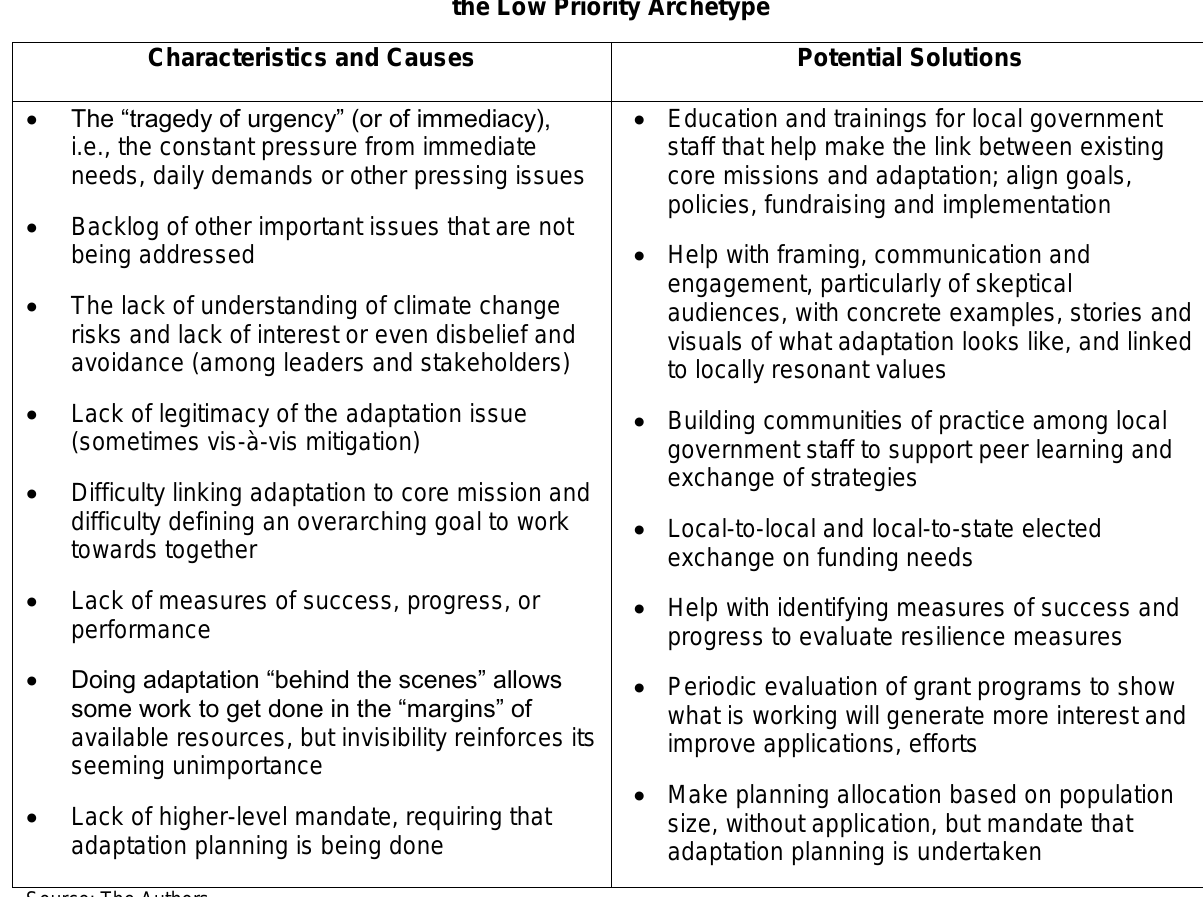
Table A2.1: Characteristics, Underlying Causes and Potential Solutions to Address